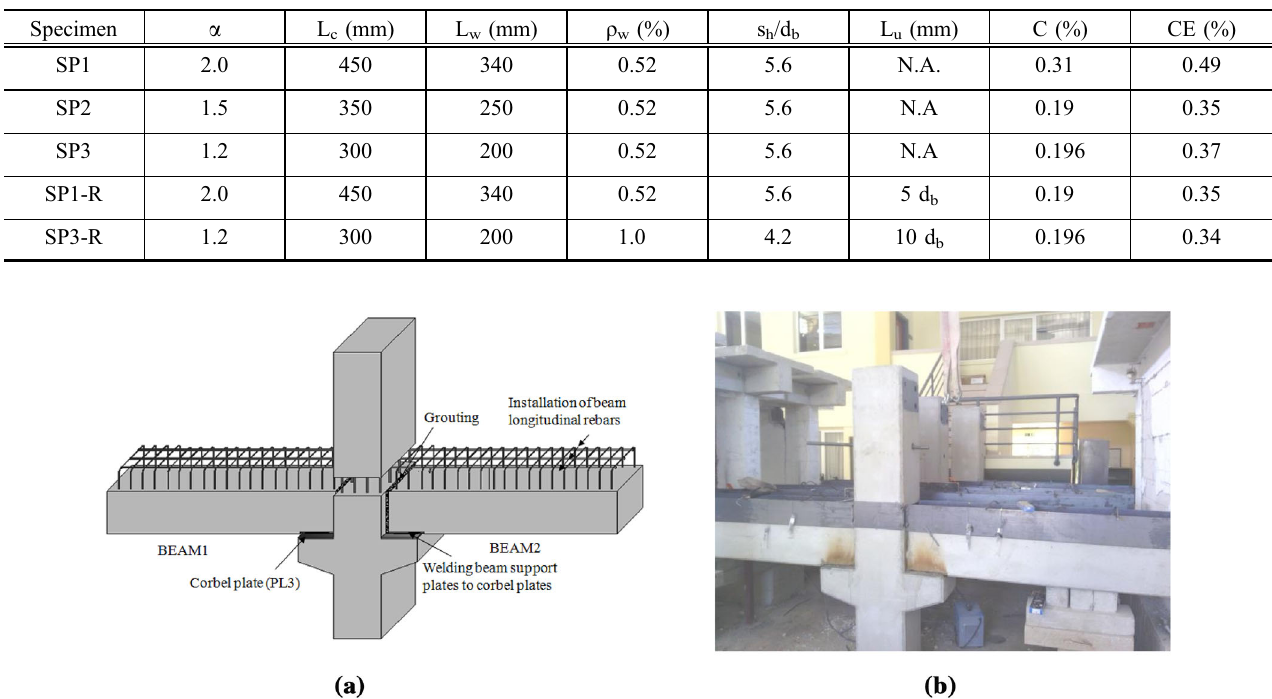
Fig. 6 a Perspective view of beam longitudinal rebars welded to beam support plate (PL-1) and b stirrups welded to additional vertical plates (2 9 PL-2). Table 2 Main test parameters and properties of precast concrete interior